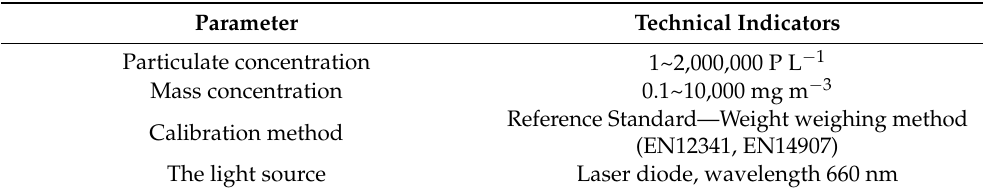
Table A2. Main technical